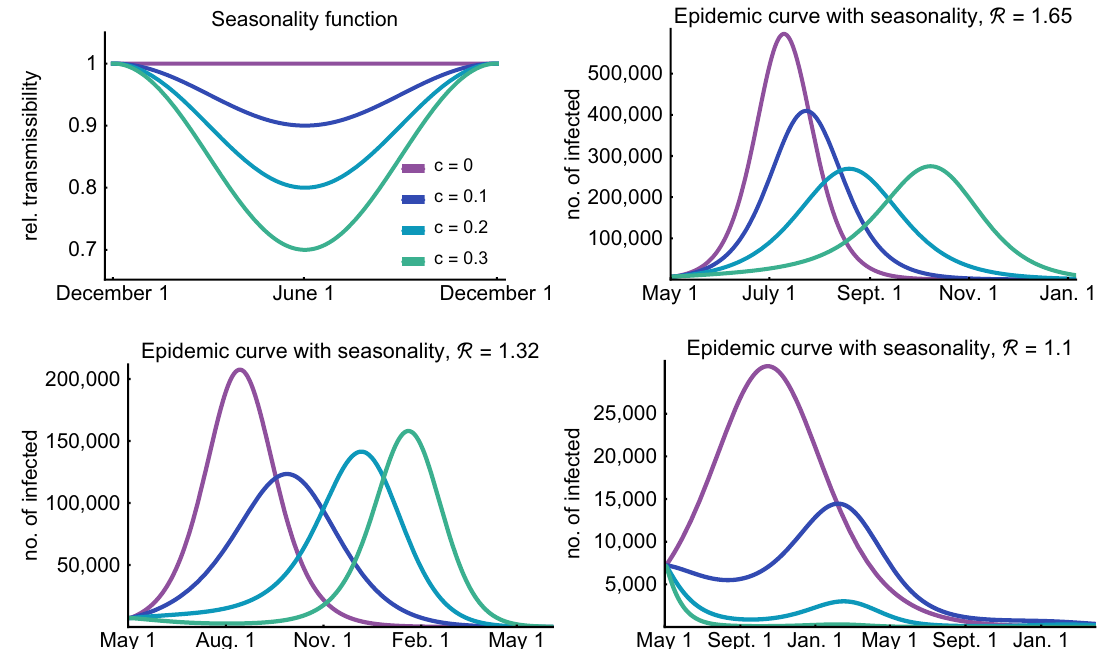
Figure 12. Effect of seasonality. The top left figure depicts the relative transmissibility of the virus throughout the year. Purple denotes no seasonality ( c = 0), blue curves correspond to weak seasonality ( c = 0.1), turquoise curves stands for moderate seasonality ( c = 0.2), and green curves correspond to strong seasonality ( c = 0.3). The next three figures investigate the number of infected individuals under these seasonality scenarios with R = 1.65, R = 1.32, and R = 1.1,